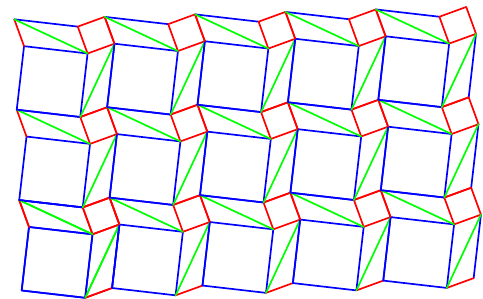
Fig. 22: Tiling with two different squares and with three equal triangles (D).